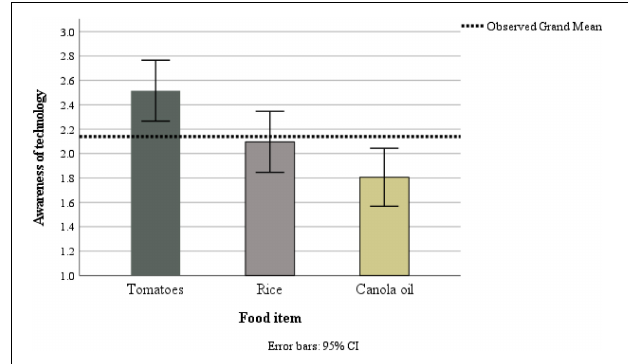
FIGURE 2 | Awareness of how the different food items could be